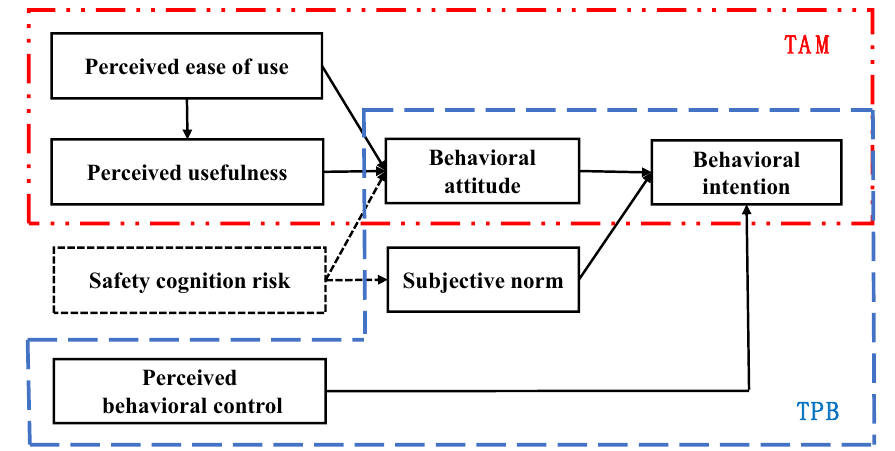
Figure 1. The improved theory of planned behavior and technology acceptance fusion